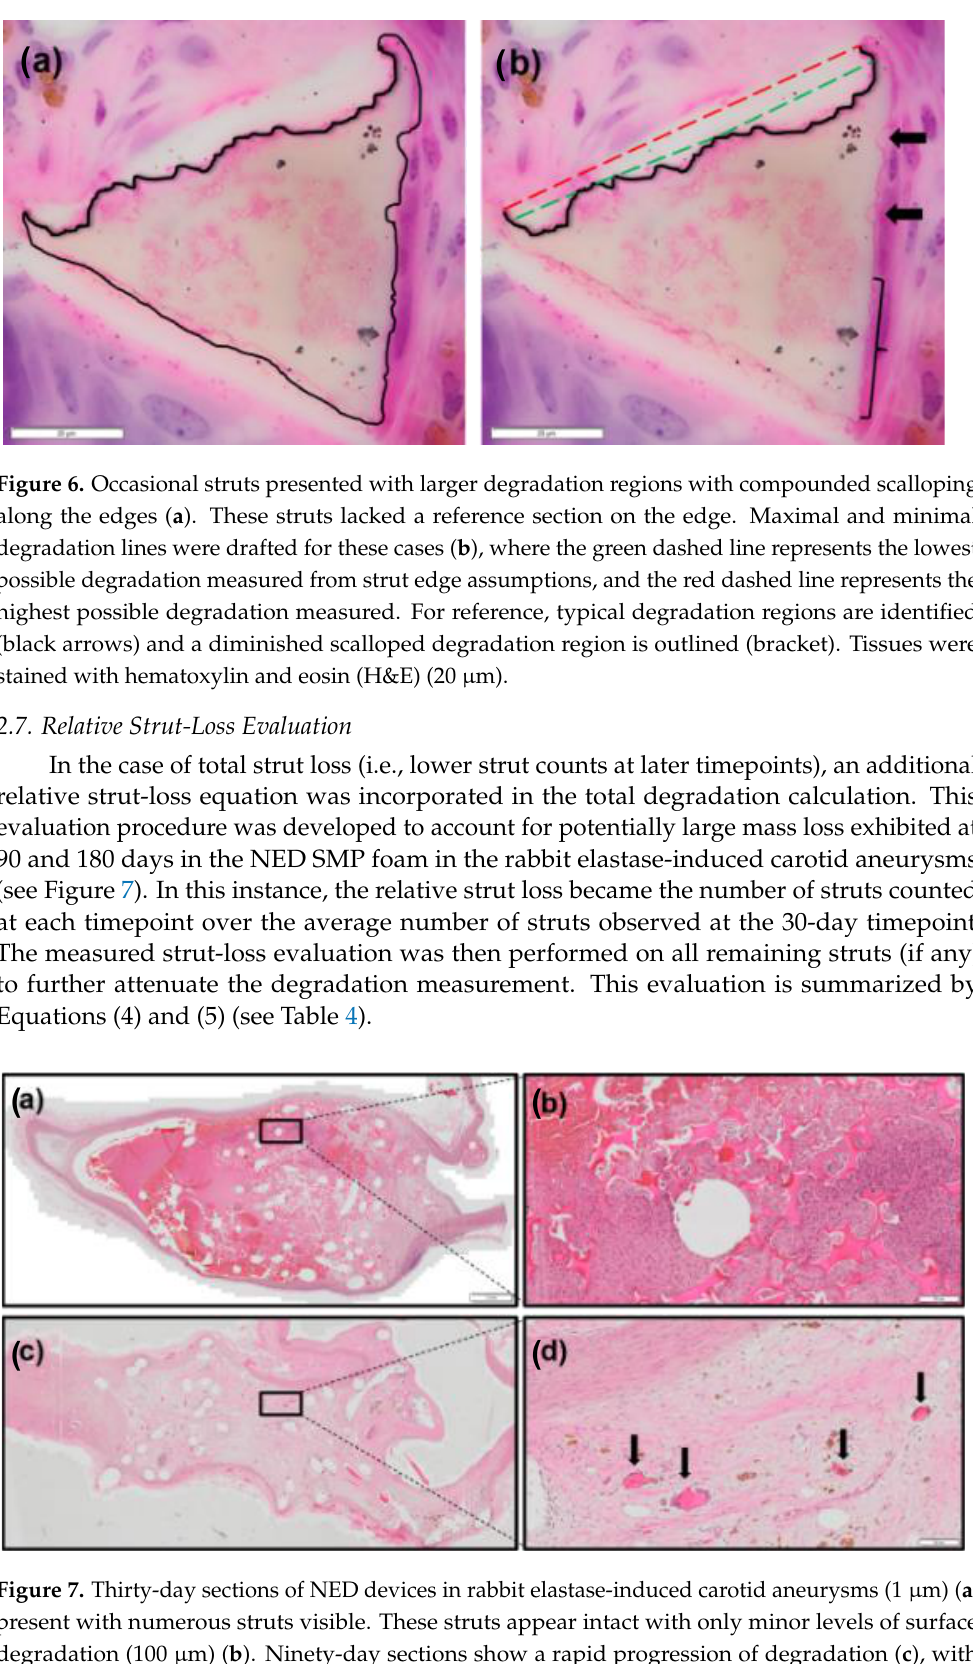
Figure 7. Thirty-day sections of NED devices in rabbit elastase-induced carotid aneurysms (1 µ m) ( a ) present with numerous struts visible. These struts appear intact with only minor levels of surface degradation (100 µ m) ( b ). Ninety-day sections show a rapid progression of degradation ( c ), with only minor groupings of struts visible, as pointed out by arrows (100 µ m) ( d ). Tissues were stained with hematoxylin and eosin